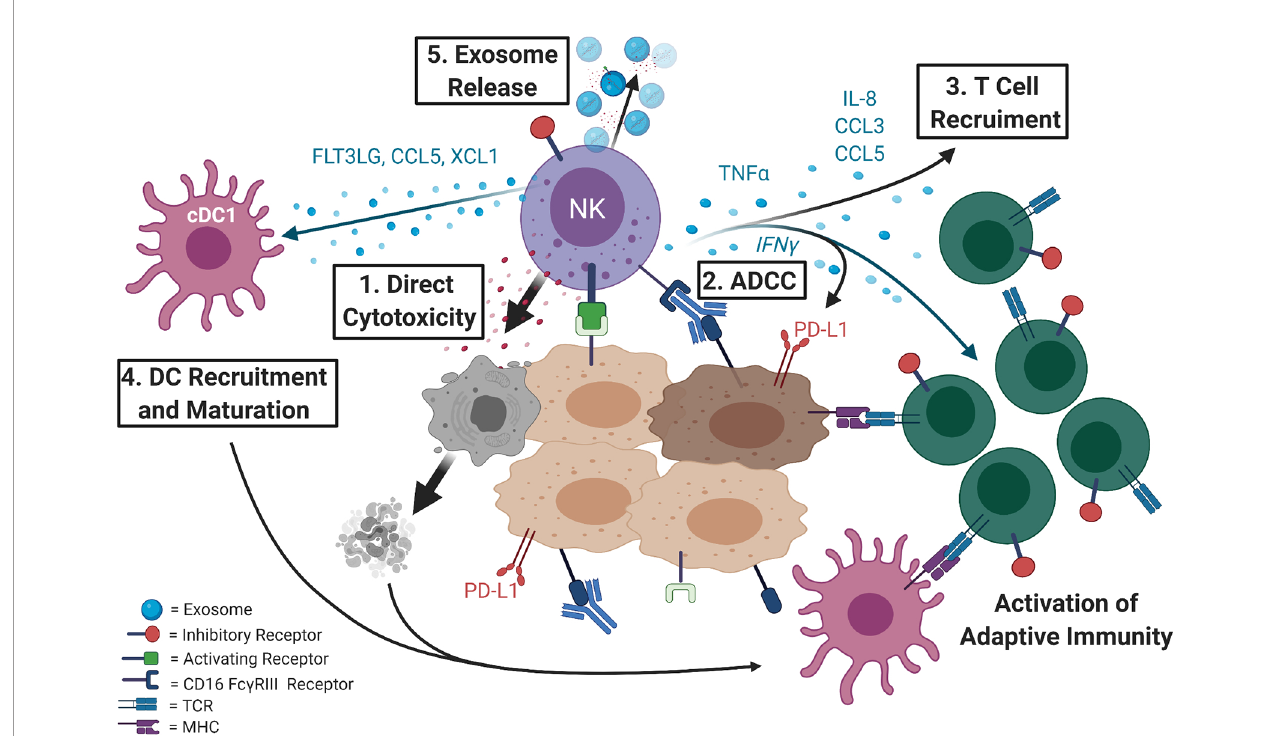
FIGURE 1 | NK cells are key effectors of anti-tumor response and direct both the innate and the adaptive arms of the immune system. 1) NK cells are the fi rst responders of the immune system and can directly recognize and lyse tumor cells. Activating receptors on NK cells recognize ligands that are mostly expressed on compromised cells while inhibitory receptors bind to self-ligands that mark healthy, normal cells. 2) NK cells also express the CD16 Fc g RIII receptor that binds antibodies and triggers antibody-dependent cellular cytotoxicity (ADCC). This response contributes to ef fi cacy of many of the antibody-based cancer therapeutics (e.g. Herceptin or Erbitux). 3) NK cells not only directly lyse compromised cells causing release of tumor antigens, but when activated release cytokines such as TNF- a and IFN - g , the later known to induce PD-L1 expression, that can recruit other immune cells and in fl ame or “ heat up ” the tumor microenvironment priming it for immunotherapy. 4) Intratumoral NK cells produce chemoattractants CCL5 and XCL1 (5) as well as FLT3LG, the formative cytokine of rare intratumoral stimulatory dendritic cells (cDC1) (6) that can activate the adaptive immune response. NK cells have also been shown to directly recruit T cells by releasing cytokines such as IL-8, CCL3, and CCL5 (7). 5) Additionally, NK cells can release exosomes with cytotoxic activity and can contain effector miRNAs, cytokines, and display NK cell surface